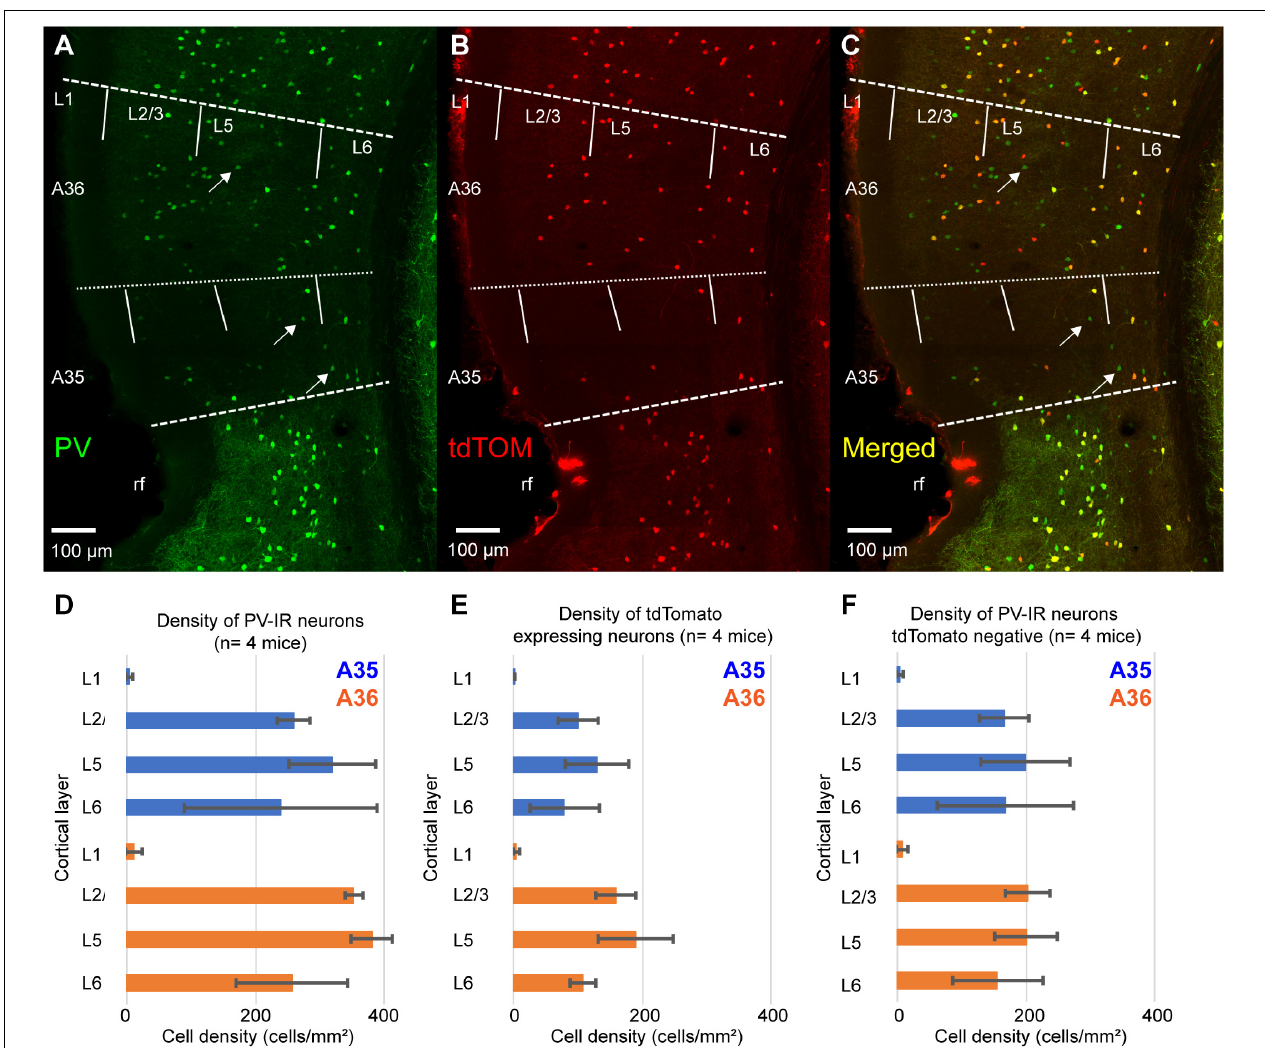
FIGURE 2 | (A–C) Representative confocal stacks showing immunofluorescence for PV (A) , tdTomato (B) and the overlap of the two signals (C) in PER of a PV-IRES-Cre mouse. Arrows indicate PV-IR neurons that do not express tdTomato. rf, rhinal fissure. (D) Bar graph showing the density of PV-IR neurons across the layers for A35 and A36. (E) Bar graph showing the density of tdTomato-expressing neurons across the layers of A35 and A36. (F) Bar graph showing the density of PV-IR that do not express tdTomato across the layers of A35 and A36.